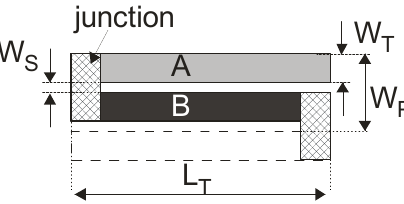
Figure 4. Dimensions used to describe the thermocouple